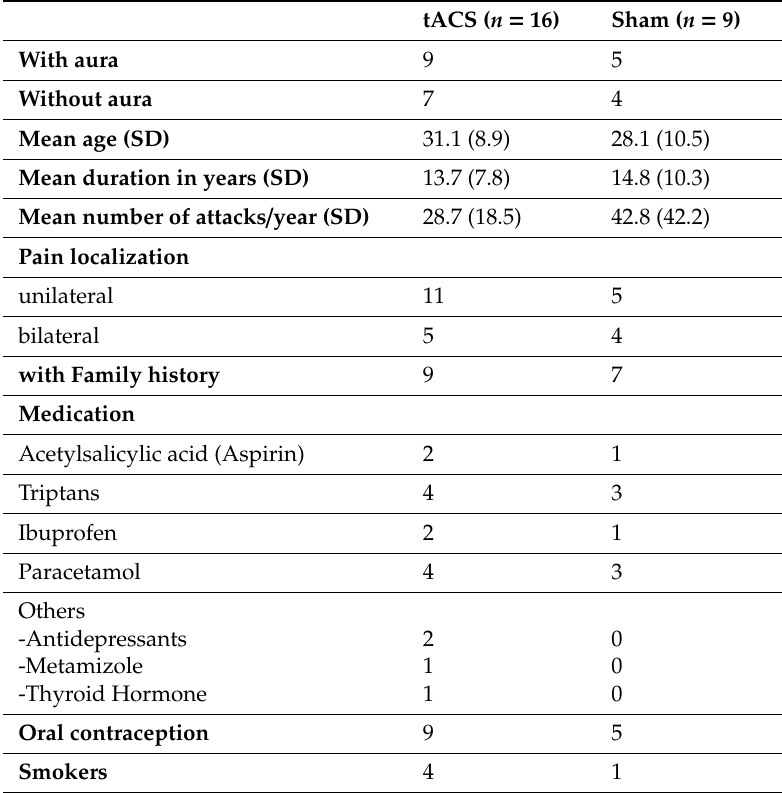
Table 1. Demographics and medical history of the patients.